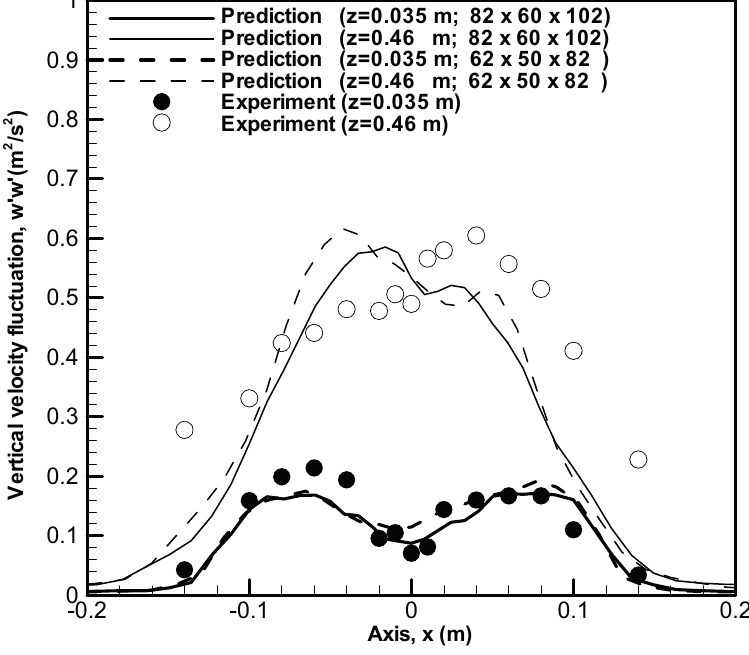
Figure 1. Profiles of the measured and predicted longitudinal velocity fluctuation, w ′ w ′ , at z = 0.035 and 0.46